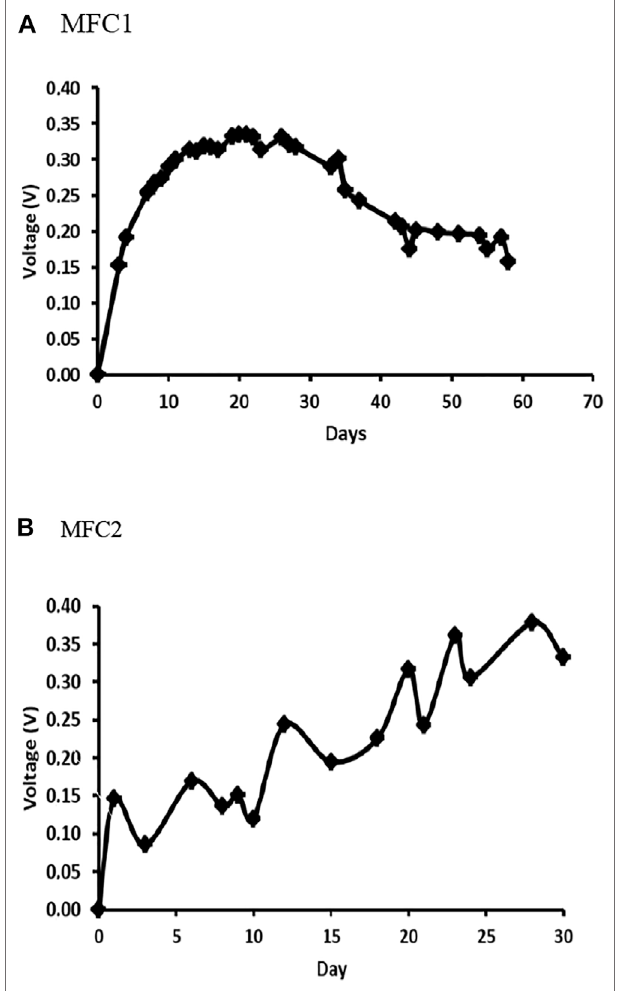
FIGURE 4 | Voltage tracking of MFCs. (A) MFC1 (B) MFC2